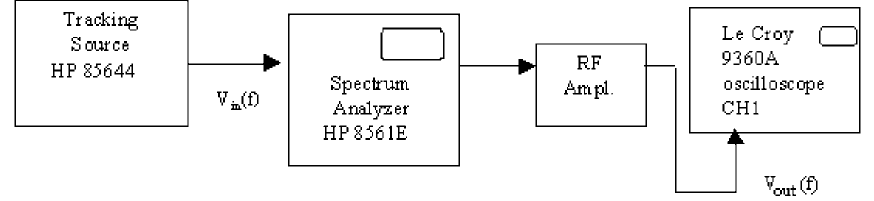
FIG. 4. Scheme of the frequency response measurement